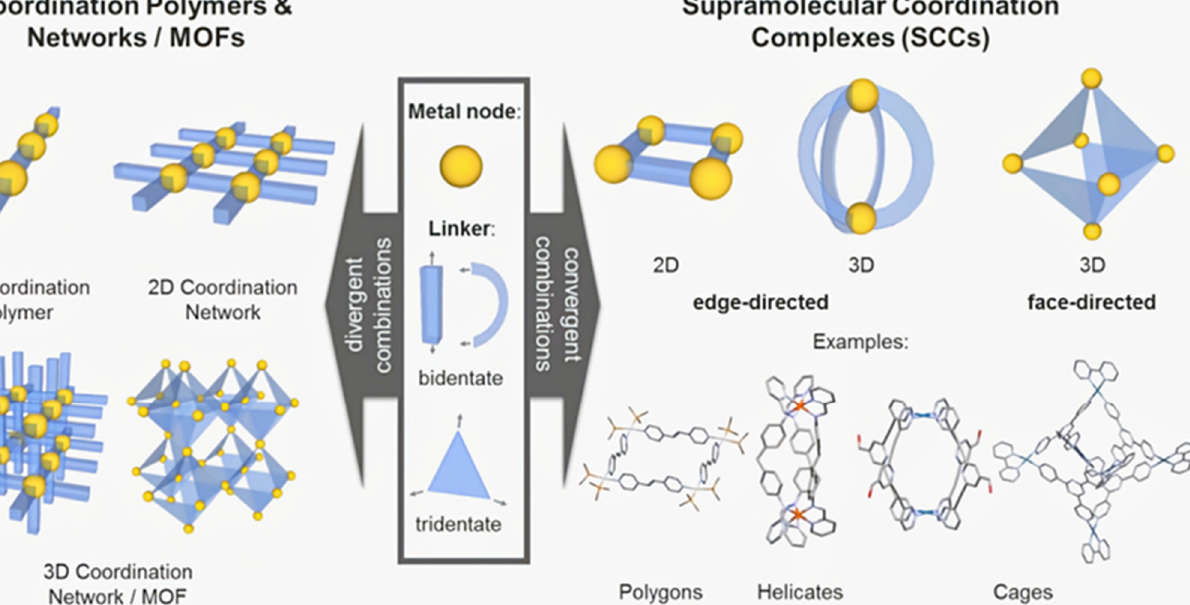
Figure 33. Illustration of two ways to achieve assemblies based on metal material: coordination polymers and networks produced by divergence ( left ) and discrete supramolecular complexes produced by polymeric combinations of organic linkers ( right ) (reproduced with permission of Ivyspring International Publisher from ref. [107]).